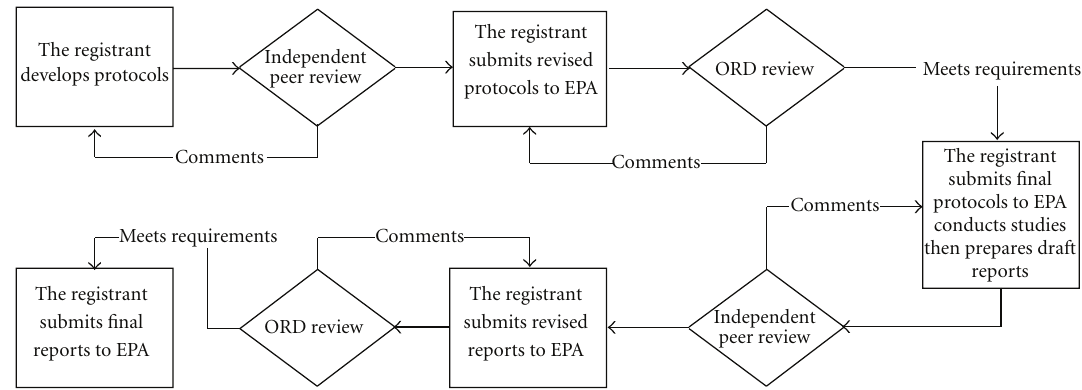
Figure 1: Schematic overview of steps used to develop and review study protocols and produce final reports. Independent peer review was carried out by the appropriate TAP. Completed final reports for all of the manganese studies can be found in the Federal Docket Management System (FDMS) at http://www.regulations.gov identified by docket number EPA-HQ-OAR-2004-0074. EPA: Environmental Protection Agency; ORD: EPA O ffi ce of Research and